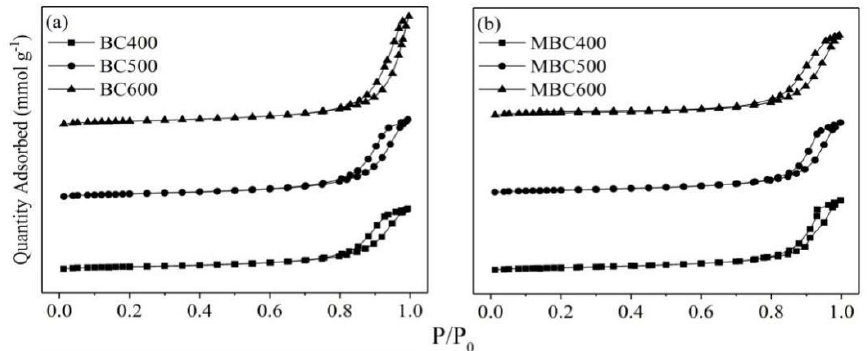
Figure 5. Adsorption – desorption isotherms of N 2 on BCs ( a ) and MBCs ( b